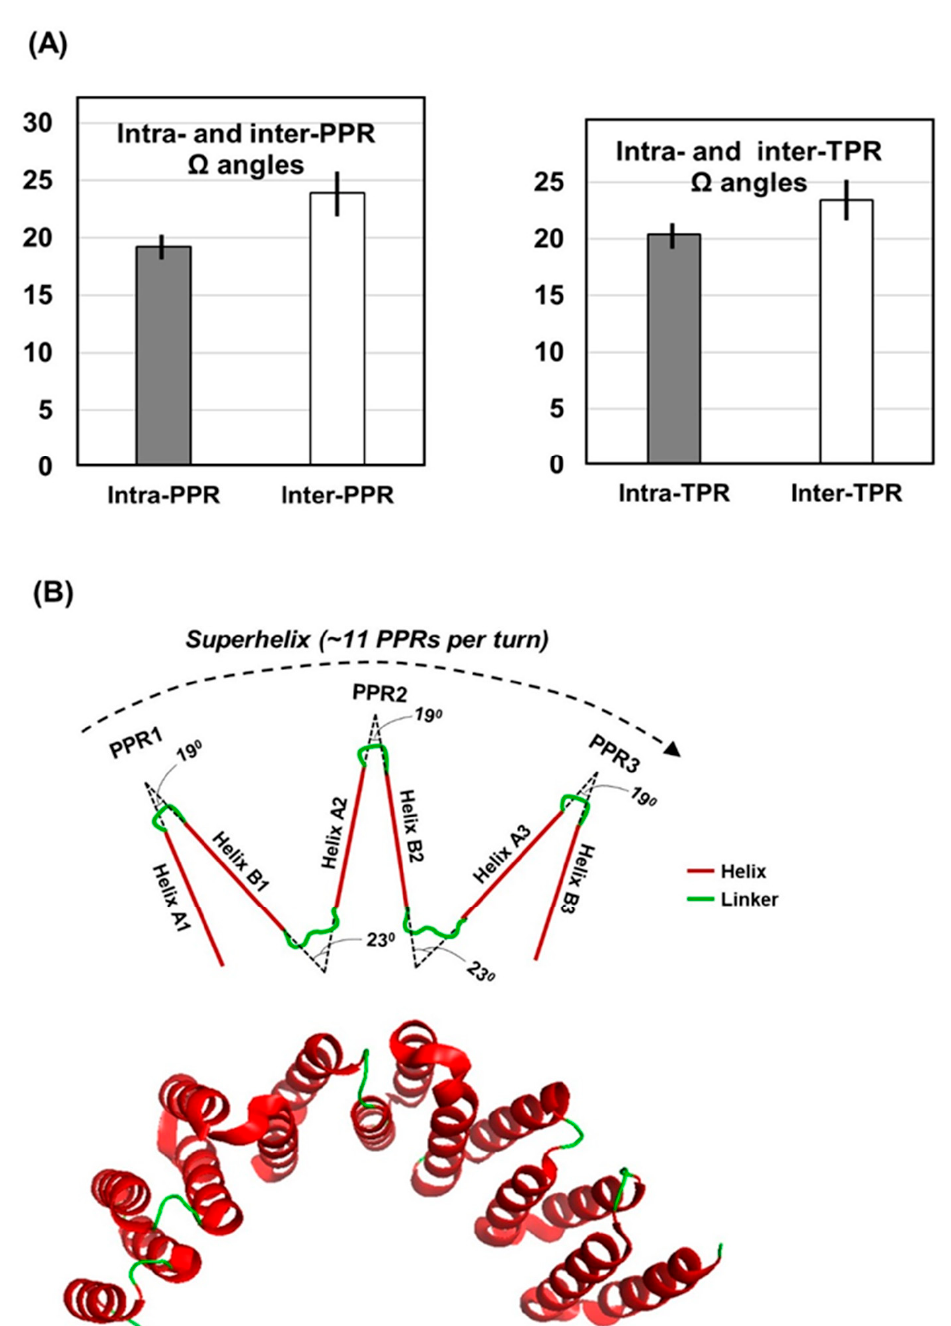
Figure 6. Helical angles in PPR domains. ( A ) Interhelical angles ( Ω ) determined from PDB crystal structures; the averages of 208 intra-PPR, 234 inter-PPR, and 216 each of intra- and inter-TPR helical angles are shown. The exact values and the standard errors are in parenthesis: intra-PPR (19.22 ± 1.37), inter-PPR (23.9 ± 3.03); intra-TPR (20.36 ± 1.63), inter-TPR (23.41 ± 3.27). ( B ) Schematic of location of the inter-and inter-repeat helical angles are located in the context of a superhelix, which was found to contain approximately 11 PPRs per complete turn. For a realistic perspective, an actual superhelix of a multi-TPR domain (PDB 5C9S, a portion of which was shown in Figure 5B) is shown below. Note that the superhelices of PPR and TPR are virtually